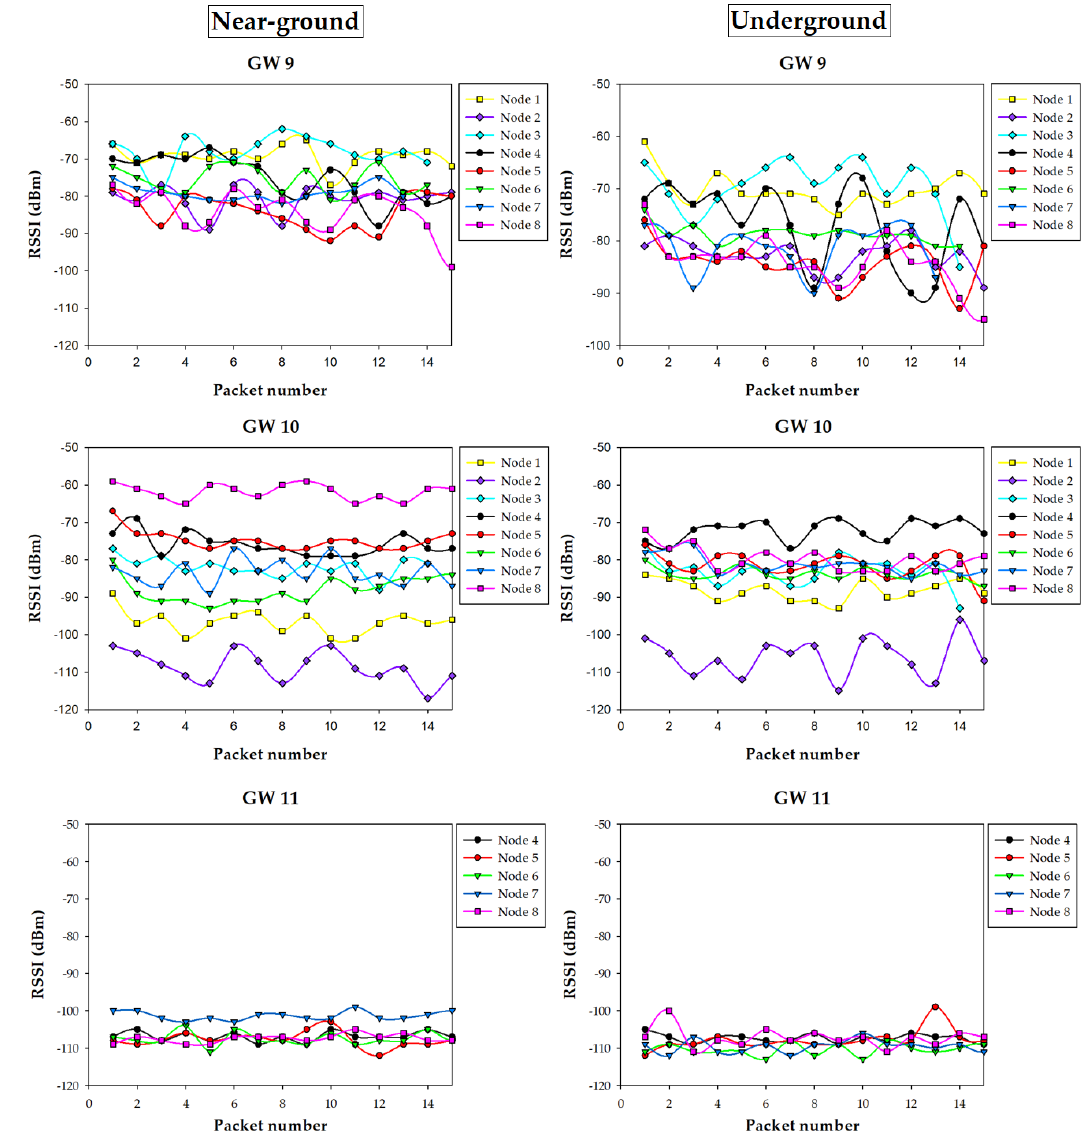
Figure 19. Summary of the measurements at 868